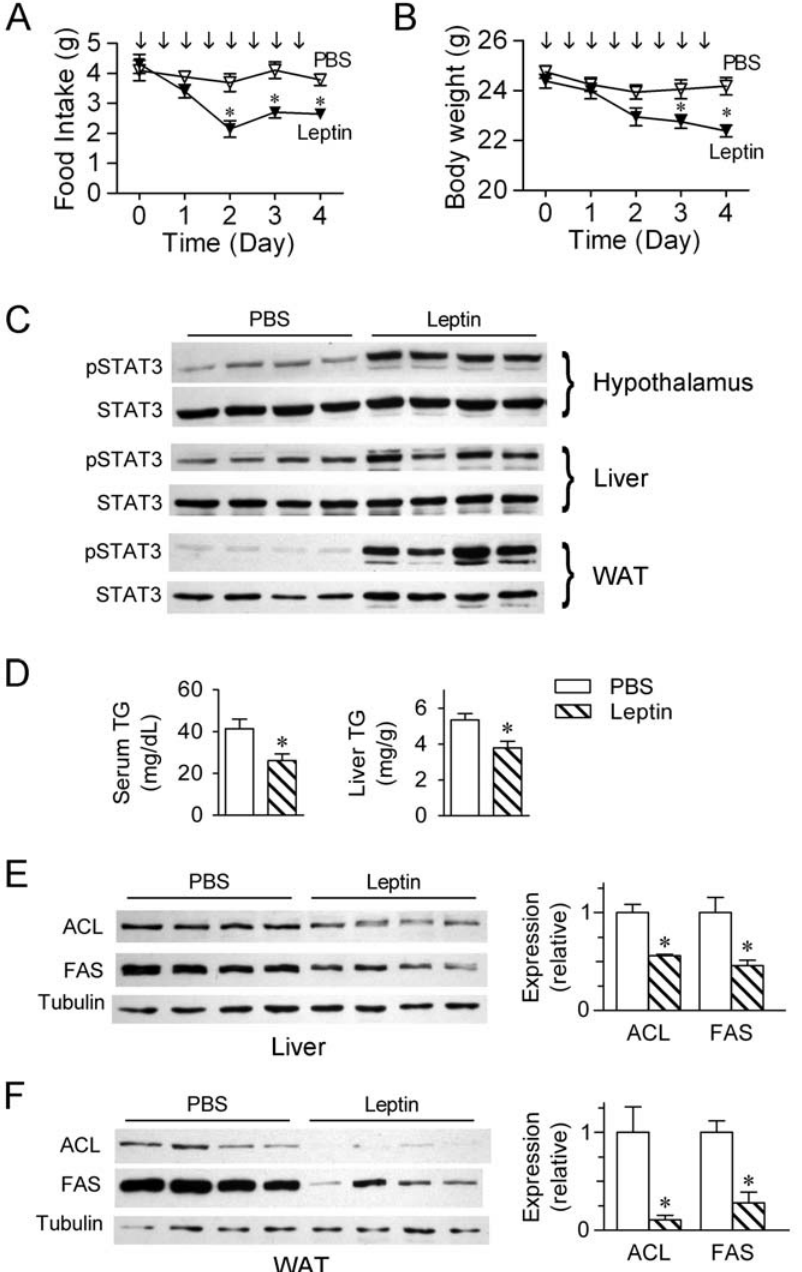
Figure 5. Exogenous leptin suppresses the expression of lipogenic enzymes both in the liver and white adipose tissue. C57BL/6 male mice at 8 weeks of age were treated with PBS vs. leptin (2 mg/kg) via intraperitoneal (i.p.) injection twice a day for 4 days, and were sacrificed 5 hours after the last injection. (A) Food intake and (B) body weight were measured daily before the dark cycle, and arrows indicate the time points of leptin injections. (C) Western immunoblots showing leptin-stimulated activation of STAT3 in the hypothalamus, liver and white adipose tissue, as detected by the indicated antibodies. (D) The triglyceride (TG) levels both in the serum and liver were measured after leptin administration. (E–F) Protein levels of ACL and FAS in the liver (E) and WAT (F) were analyzed by Western immunoblot, with quantification results shown in the bar graphs. Data in all panels are presented as mean 6 SEM (n=4–5/group); * p , 0.05 vs. PBS-treatment group. searching protein sequence databases (NCBI Nonredundant Protein Database).